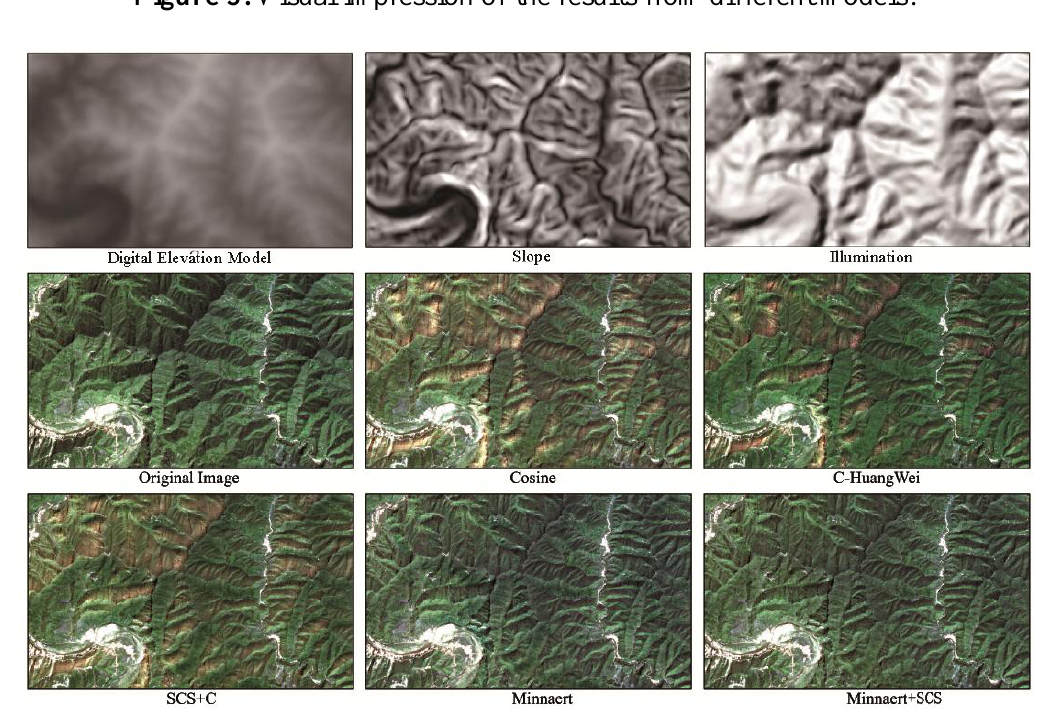
Figure 5. Visual impression of the results from different